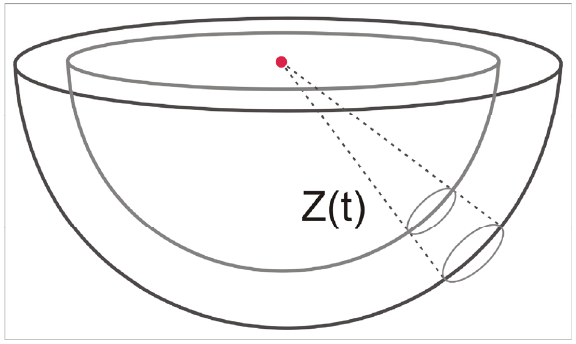
Figure 2. Explanation scheme of spherical divergence.